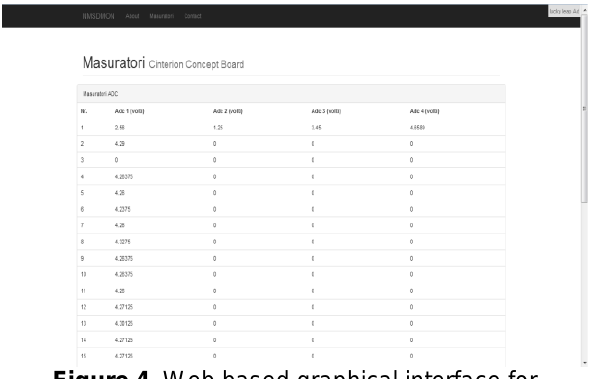
Figure 4. Web based graphical interface for visualizing data on the presentation